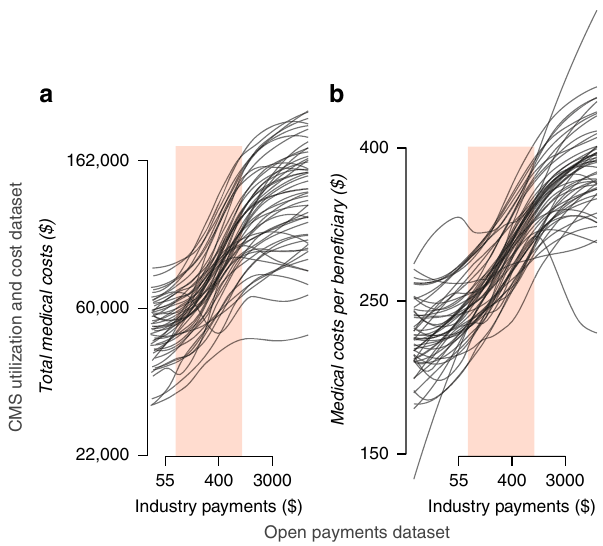
Fig. 1 Exploring the relationship between industry payments to providers and medical costs. Each line represents a loess smoother of the scatterplot of the providers within each state (see Methods for details). The shaded bands mark the middle 50% of the distribution of payments. Both axes are displayed on the log scale. The data displayed on the x axis comes from the Open Payments data set (openpaymentsdata.cms.gov); the data displayed on the y axis comes from the CMS Utilization and Cost data set (cms.gov). See also Supplementary Fig. 1. a Total industry payments versus total annual medical (non-drug) costs of each provider. b Total